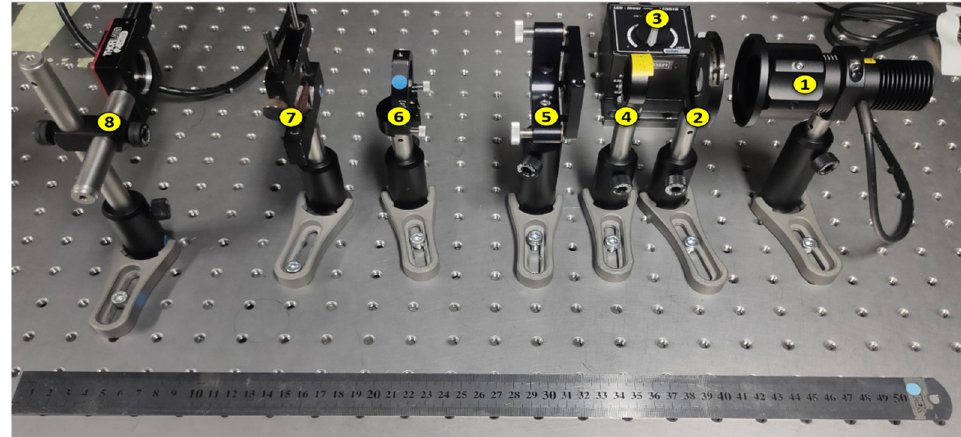
Figure 9. Photograph of the experimental setup: (1) LED, (2) iris, (3) LED power source, (4) lens L1 (f = 50 mm), (5) test object, (6) lens L2 (f = 80 mm), (7) LADISA, (8) image sensor. For the reconstruction, the PSFs were synthesized directly from the recorded images.